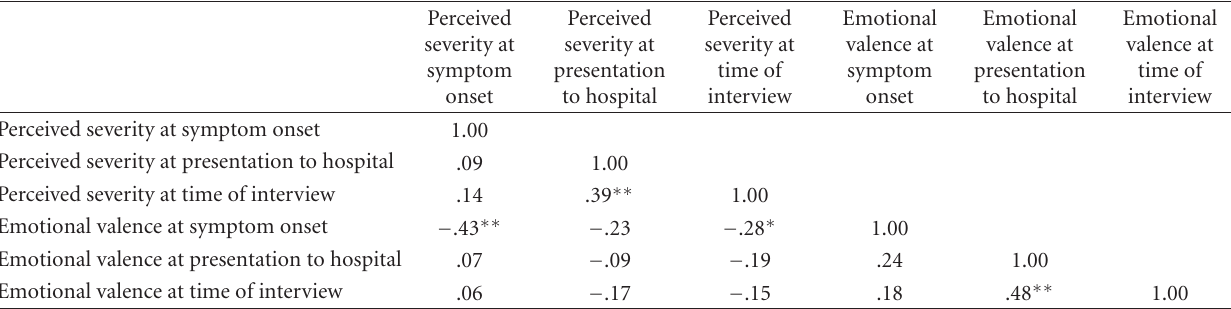
Table 2: Correlation coe ffi cients for perceived event severity over the three time